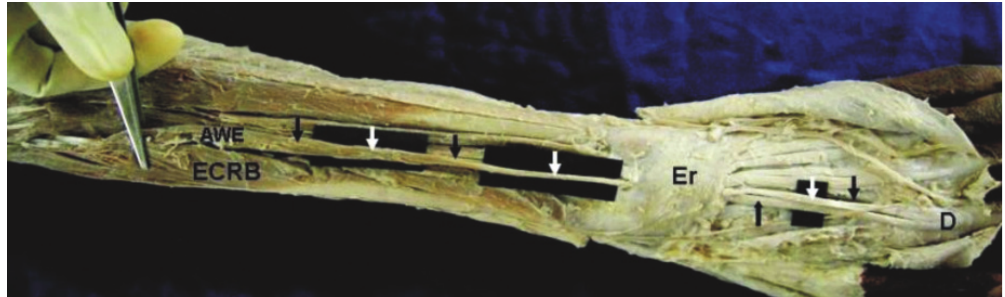
Figure 1 - Extensor compartment of the left forearm and hand region. AWE, additional wrist extensor; D, dorsal digital expansion for the index finger; ECRB, extensor carpi radialis brevis; Er, extensor retinaculum. The course of the additional muscle is shown by the downward facing arrows. The upward facing arrow indicates the tendon of extensor indicis muscle.